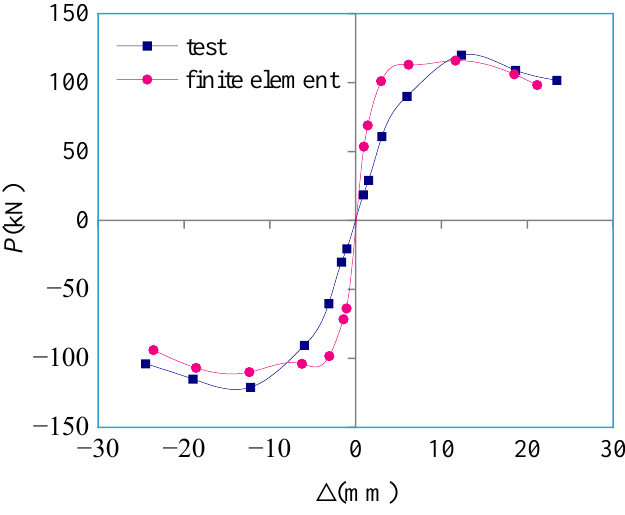
Figure 17. Finite element model ( a ) Loads and boundary conditions ( b ) Meshing.